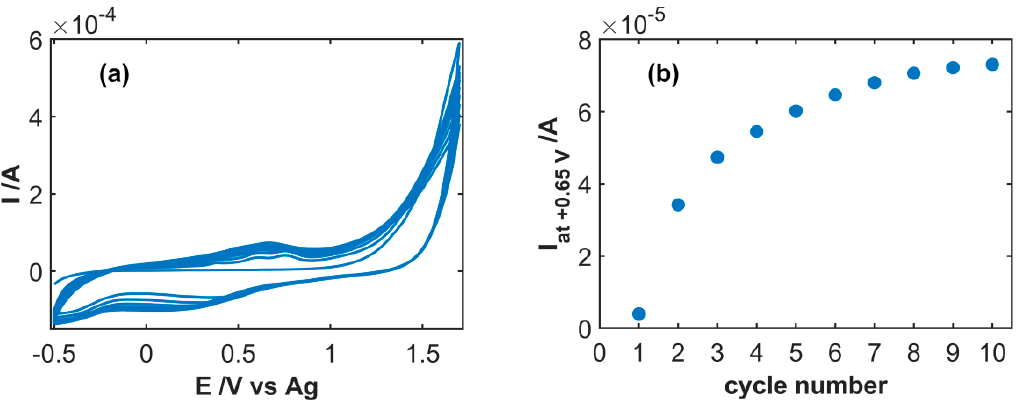
Figure 2. ( a ) Ten consecutive cyclic voltammetry (CV) traces collected during SWCNT oxidation in 1 M H 2 SO 4 at 0.1 Vs − 1 ; ( b ) evolution of the current intensity at +0.65 V in the forward scan.